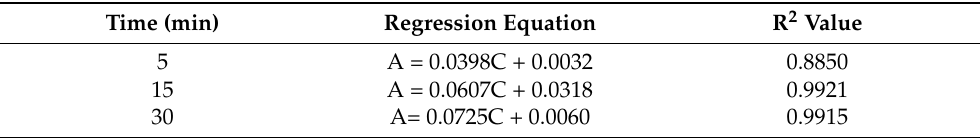
Table 9. Regression equations obtained at fixed times of 5, 15, 30, 45, 60, 75, and 90 min for the determination of TIGC employing CTC formation with